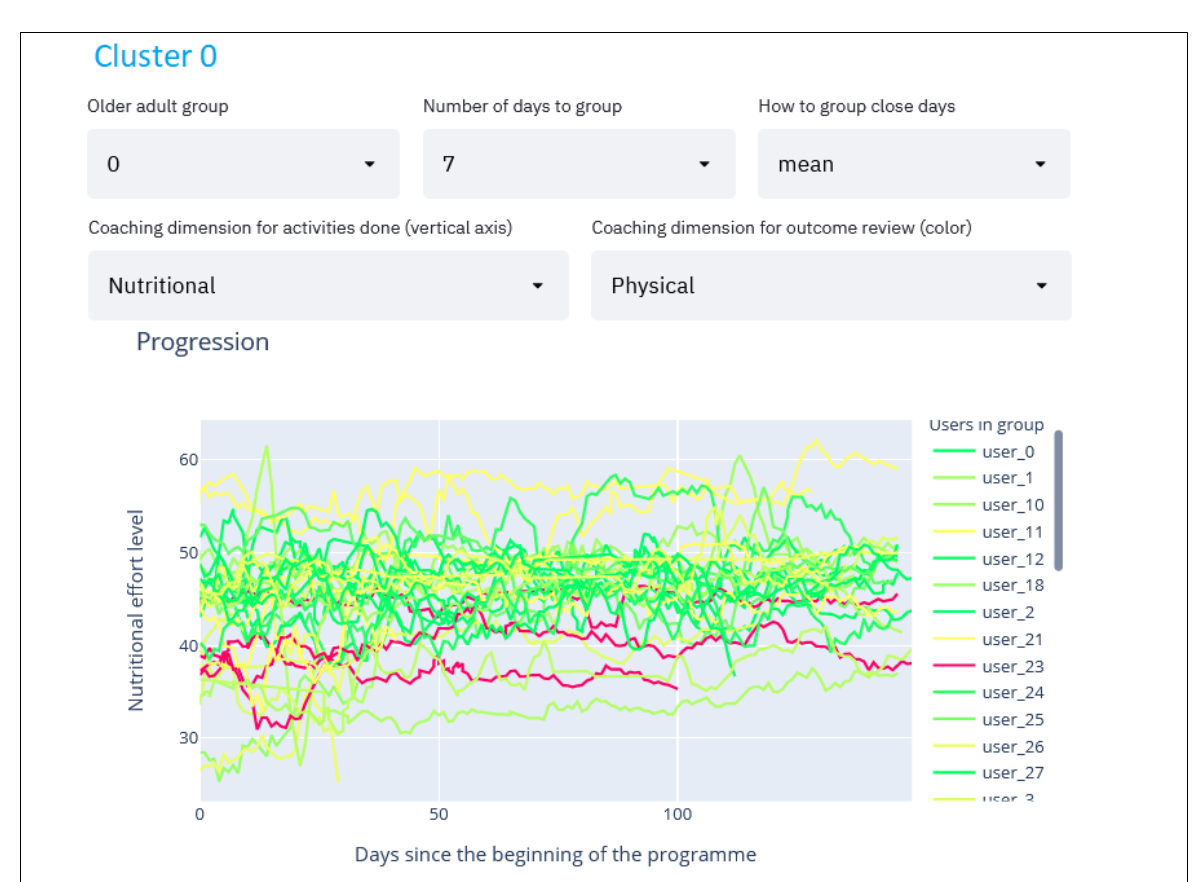
Figure 9. Evolution graph of Group 0. Showing the nutritional activity level and coloring by physical improvement.